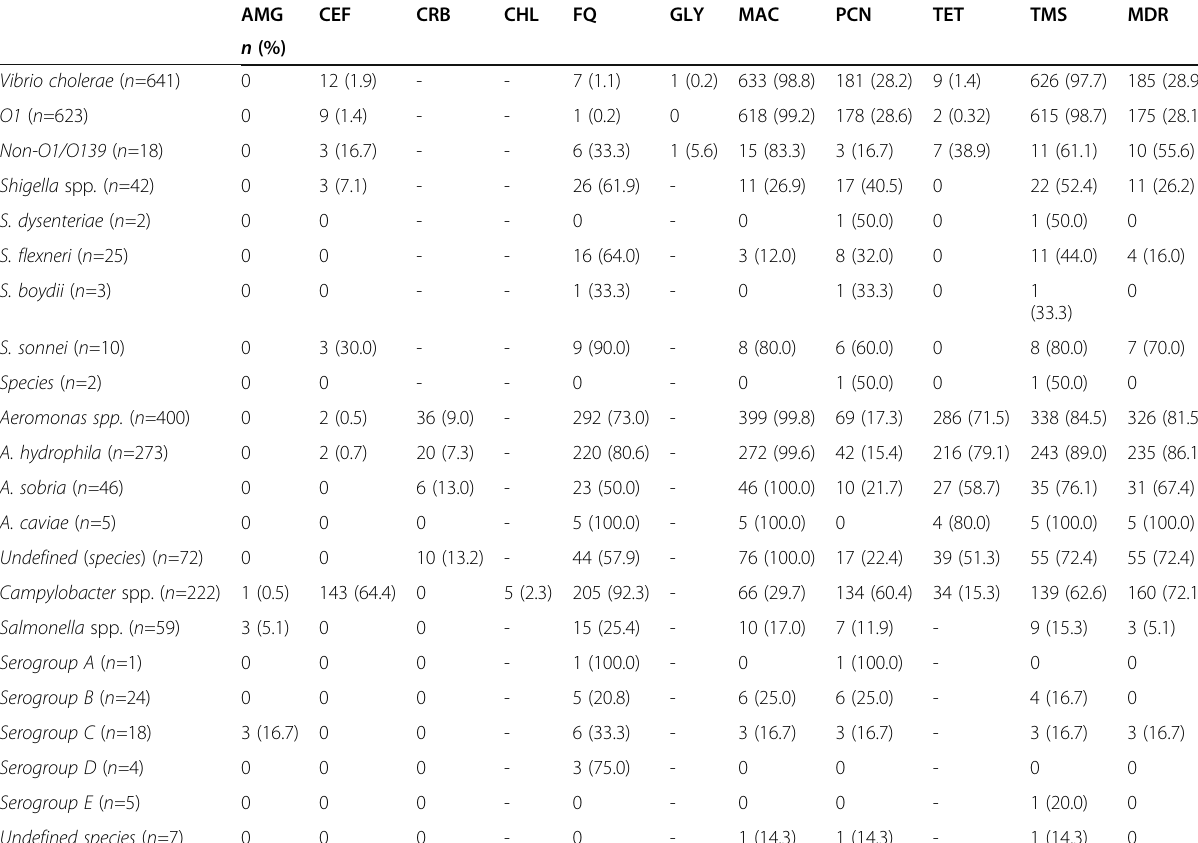
Table 2 Antimicrobial resistance patterns of stool isolates